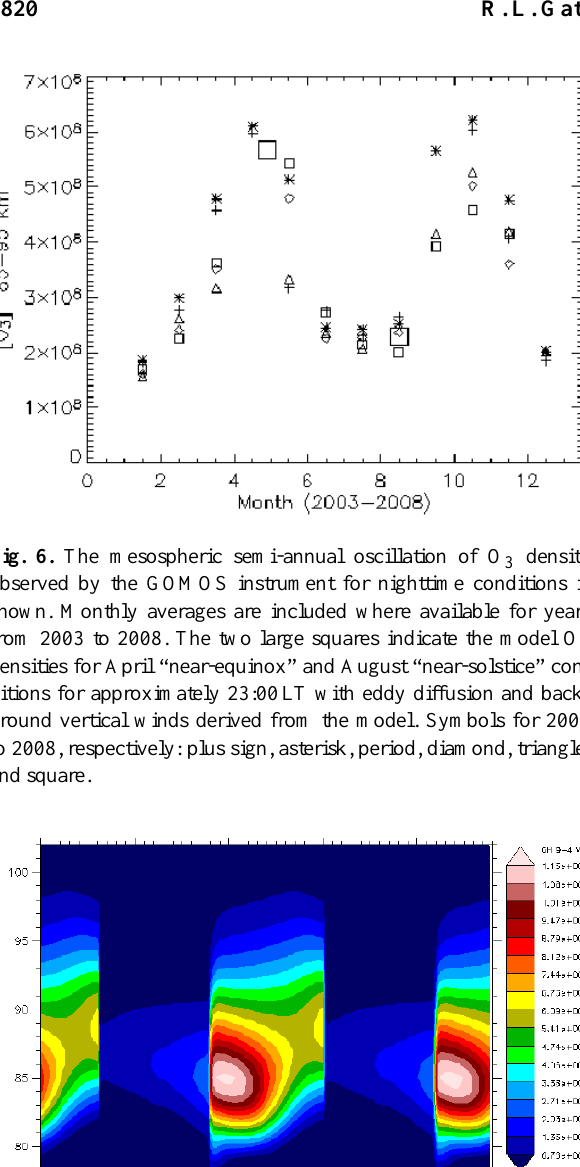
for the OH ∗ 9-4 Meinel emission band. Model volume